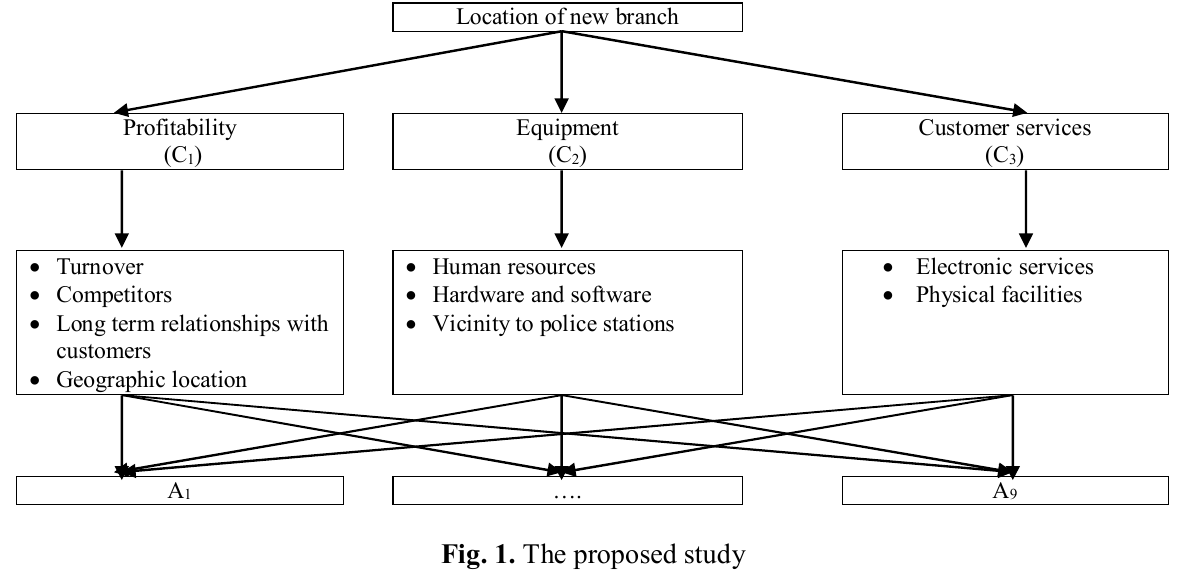
Fig. 1. The proposed study